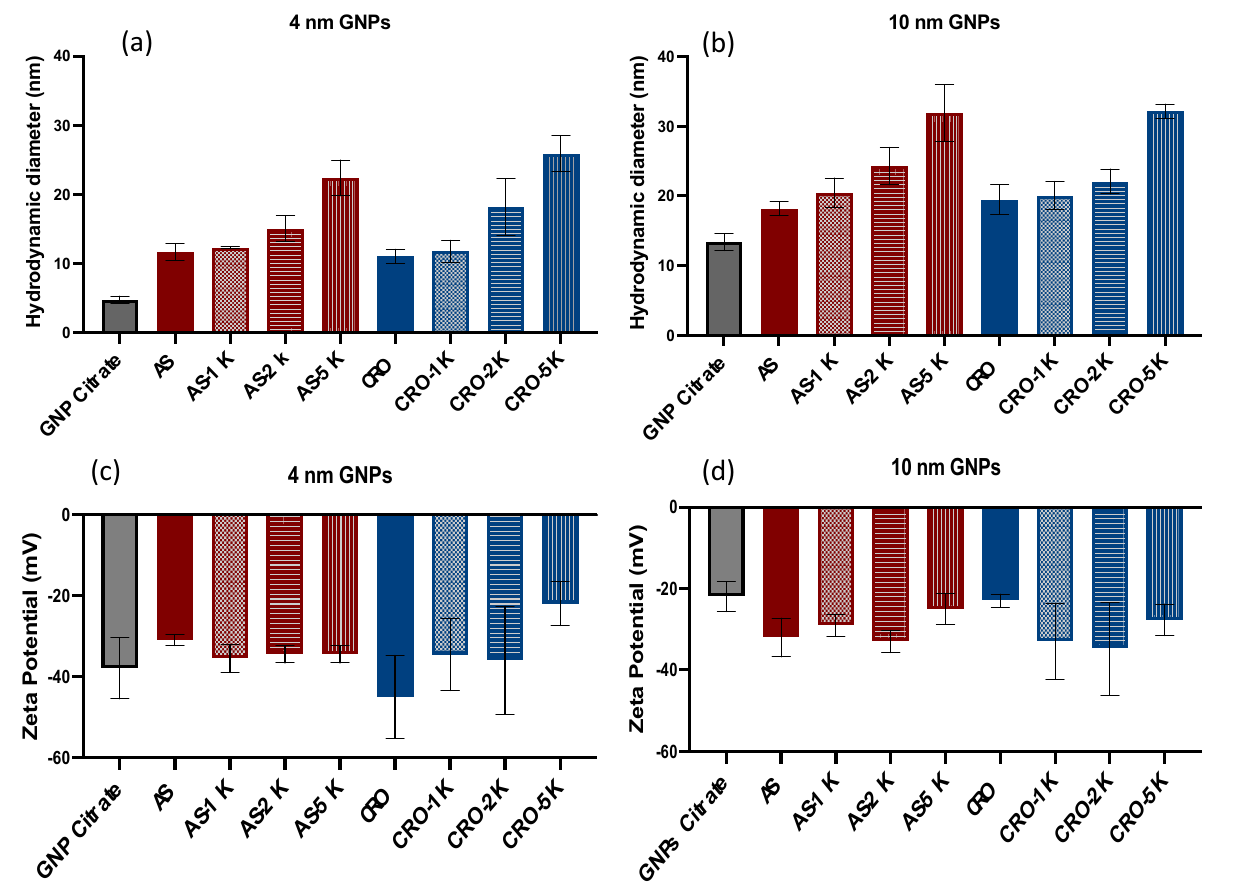
Figure 2. Characterization of GNPs. ( a ) Hydrodynamic diameters of 4 nm citrate-capped and conjugated GNPs and ( b ) the hydrodynamic diameters of 10 nm citrate-capped and conjugated GNPs. ( c ) ζ potential of 4 nm citrate-capped and conjugated GNPs. ( d ) ζ potential of 10 nm citrate-capped and conjugated GNPs. Each data point represents the mean ± standard deviation (SD) of triplicate measurments. The number of oligonucleotides (AS1411 and CRO) per GNP was quantified by UV– visible spectroscopy after cleaving the DNA from the particles using a DTT solution and column purification, Table 2. The number of Gd ions per nanoparticle was quantified by ICP-MS after nanoparticle digestion in Aqua Regia (Table 2). Both oligonucleotide and Gd ion numbers increase as the GNP core size increases from 4 to 10 nm and decrease as larger molecular weight PEG is added to the coating. Table 2. Quantification of oligonucleotides (AS1411/ CRO) and Gd per GNP.